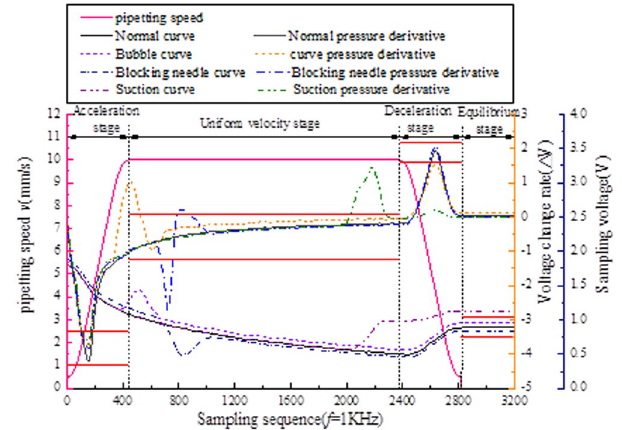
Figure 5. Comparison of the characteristics of abnormal phenomena in the migration